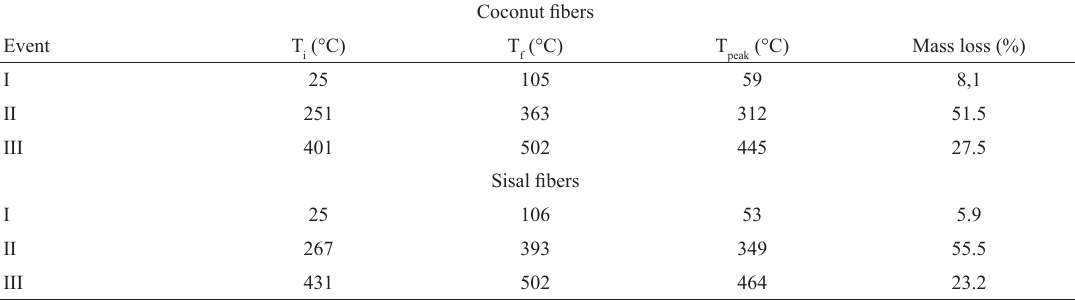
), final temperature (T ), peak temperature (T ) and the percentage mass loss of the events i f peak Coconut fibers